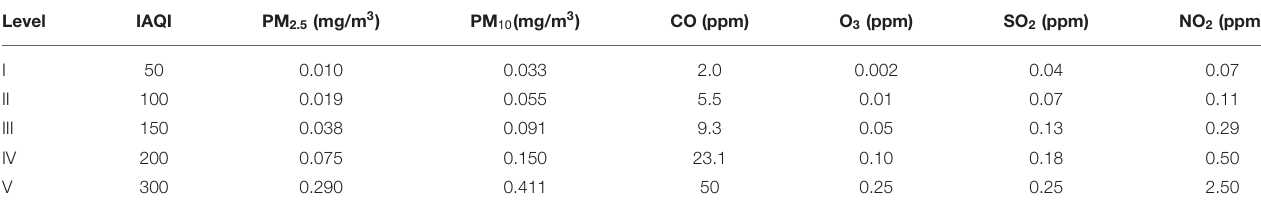
TABLE 3 | Threshold of indoor air chemical pollutants.